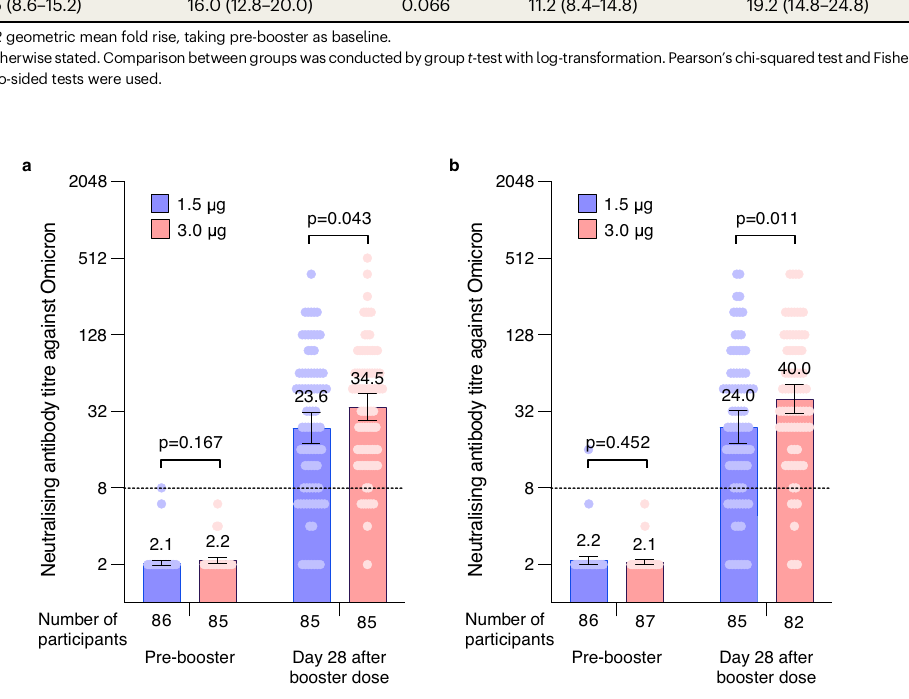
Fig. 3 | Levels of neutralising antibody against the Omicron 28 days after the third dose. a Neutralising antibody titres against the Omicron in Cohort 1. b Neutralising antibody titres against the Omicron in Cohort 2. The number of participants for 1.5 μ g group (blue) and 3.0 μ g group (red) at each visitincluded in the analysis is provided below the bars. Dots are reciprocal neutralising antibody titres for individuals in the per-protocol population. Numbers above the bars are GMTs,andtheerrorbarsindicatethe95%CI.GMTsandcorresponding95%CIwere